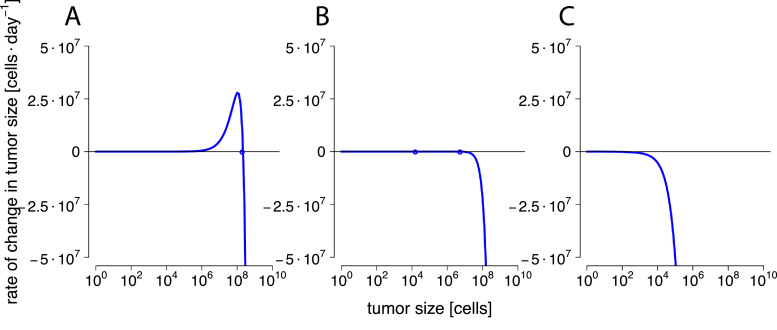
Bistability of cancer cell fixed points induced by immune control of tumor growth in model(21), (22), (23). Panels A) to C) show the function dT/dt(T) (blue lines) for different parameter values of c. c is varied from 10−7 (A) to 10−3 (B) 100 (C). The blue points indicate the numerically found roots of dT/dt(T). Bistability emerges at c=10−3. The parameter values were as specified in Table 3.